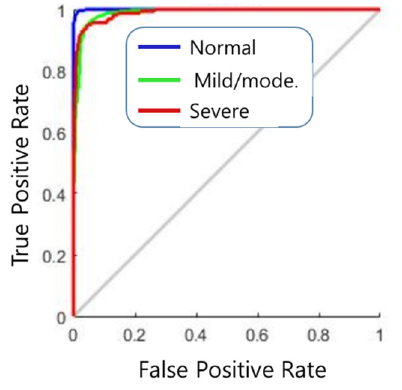
Figure 8. ROC curve of the results.